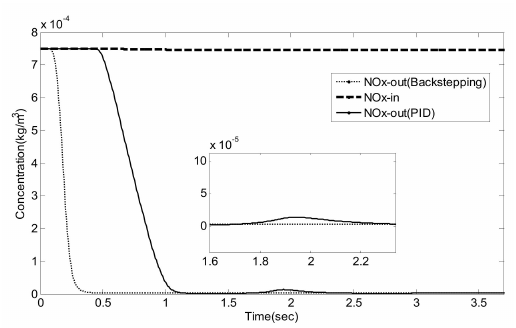
Figure 14. NO / NO 2 = 1 / 0, NOx concentration before and after the SCR